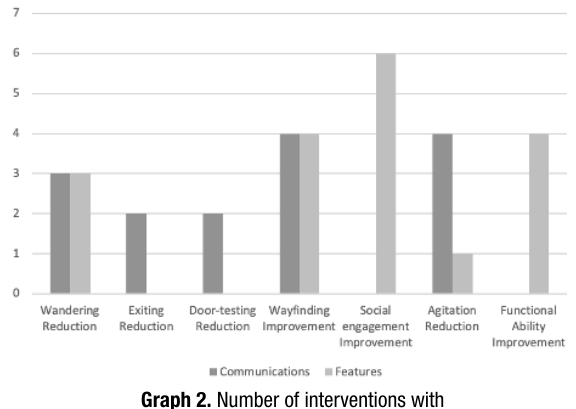
Graph 2. Number of interventions with successful results related with their